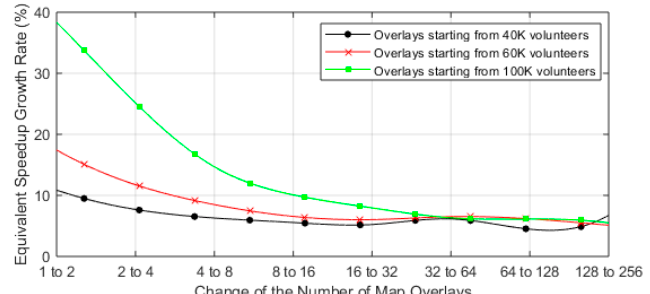
Figure 11. The equivalent speedup growth rate vs. the change of the number of map overlays.